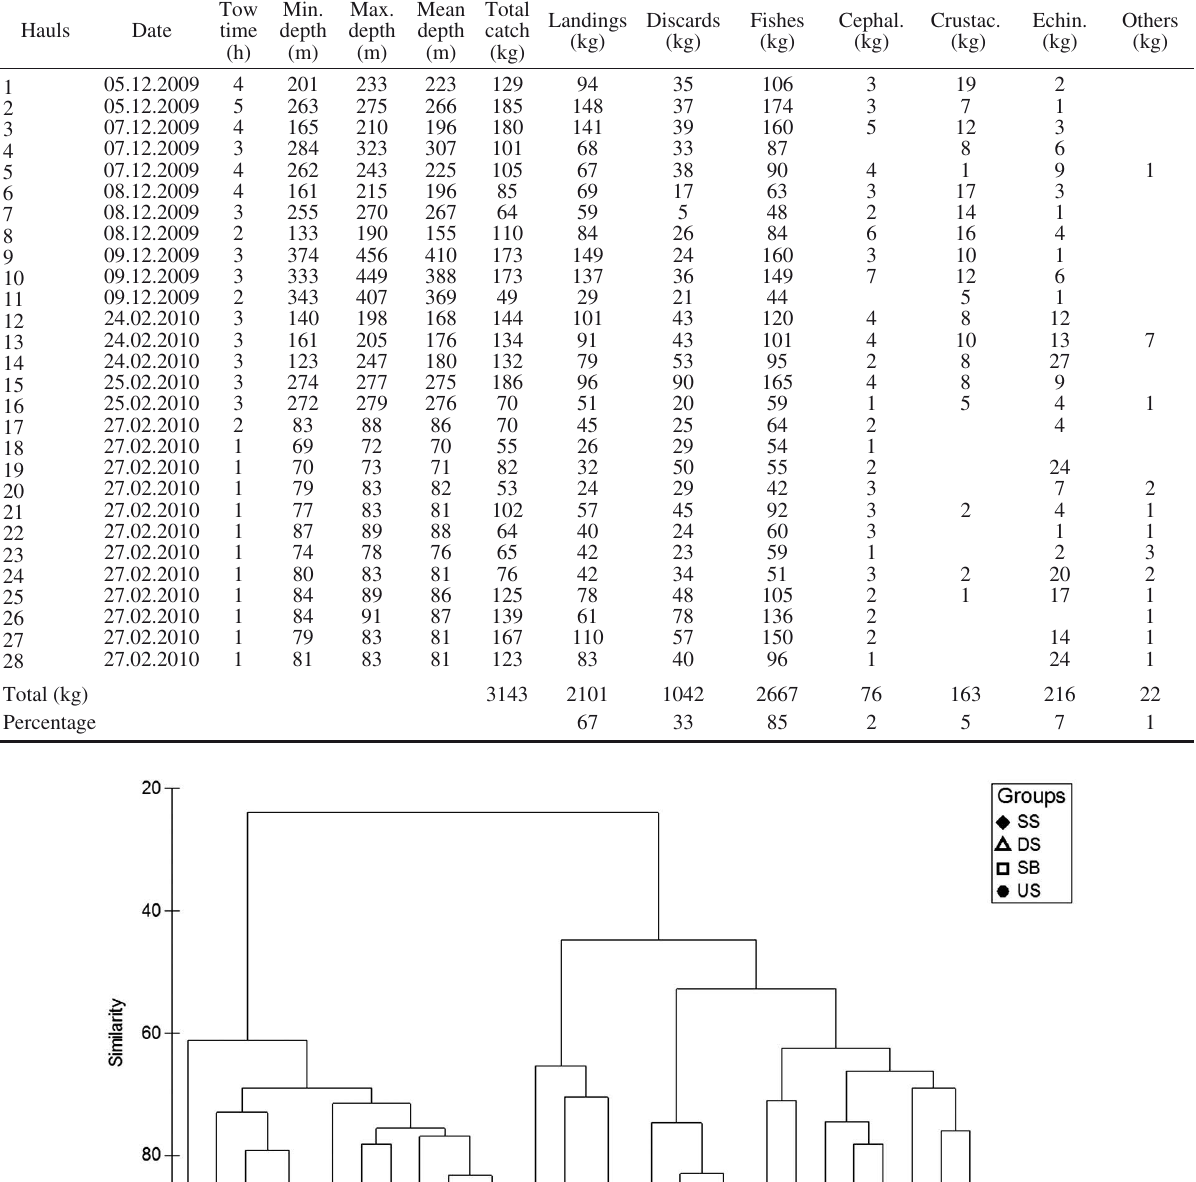
Table 1. – General summary of the results for the trawl samples analysed. Cephal., cephalopods; Crustac., crustaceans; Echin., echinoderms. Hauls